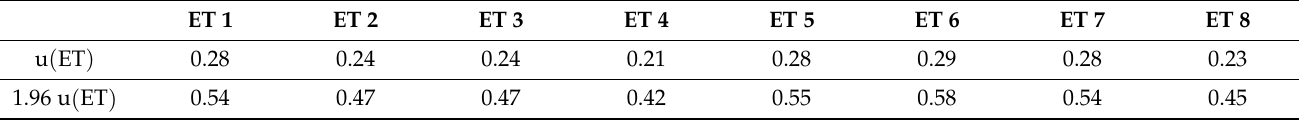
Table 4. Associated daily ET uncertainties for each lysimeter in mm. u ( ET ) values refer to the standard uncertainty and 1.96 u ( ET ) the uncertainty for a 95% confidence